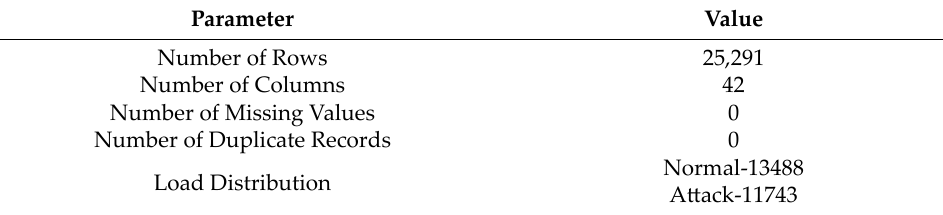
Table 6. Details of NSL_KDD Training dataset.